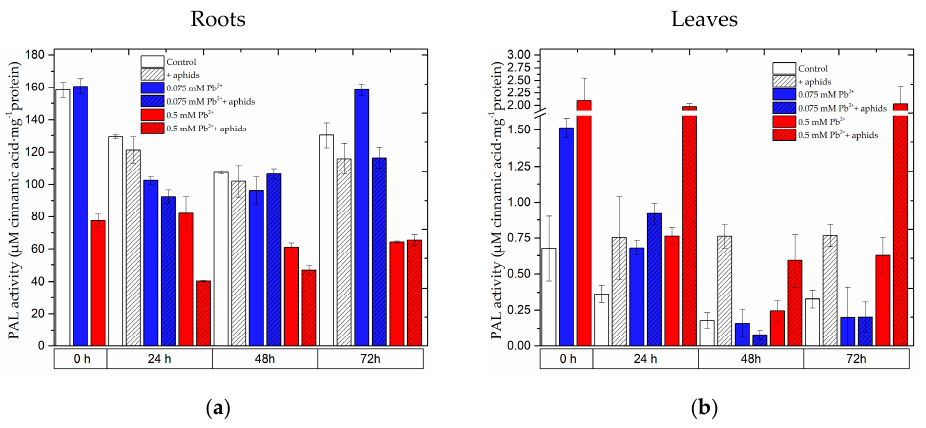
Figure 8. The effect of lead and A. pisum on activity of phenylalanine ammonialyase in roots ( a ) and leaves ( b ) of pea seedlings. The data were obtained in three independent experiments and statistically analysed using ANOVA ( p -values at α = 0.05). Hypotheses on the equality of means were verified by the two-sample t -test. To account for multiple testing, we used the Bonferroni correction (statistically significant differences are shown in Table